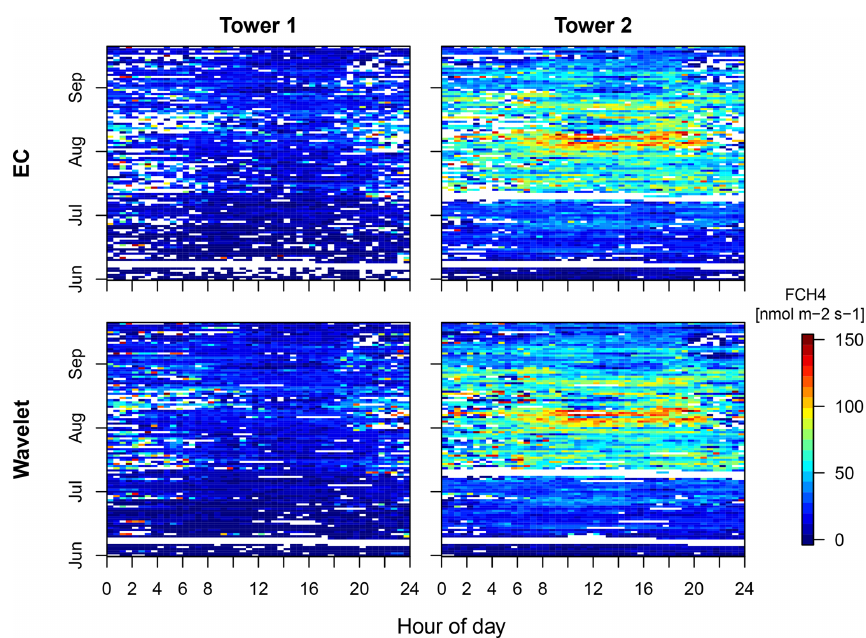
Figure A1. Fingerprint plots showing the diurnal distribution of flux rates and gaps (white) for both towers and processing methods.